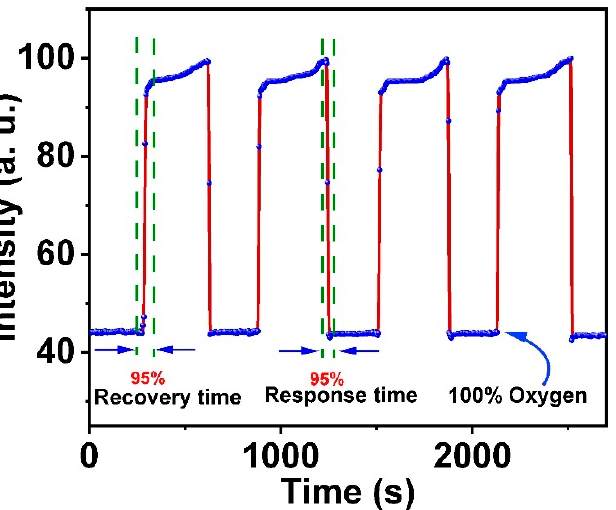
Figure 13. Response times and reversibility of the O 2 ormosil nanosensor on switching between 100% O 2 and 100% N 2 under excitation at 365 nm; emission was detected at 648 nm.